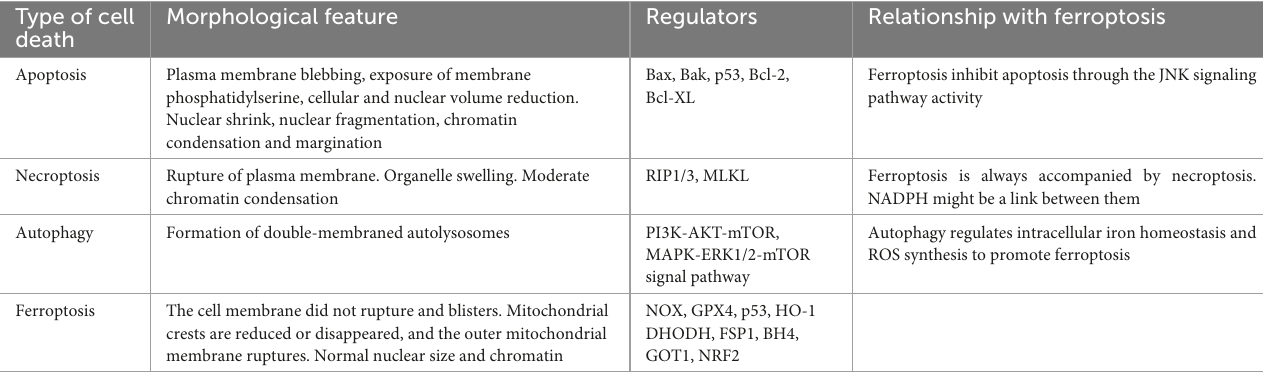
TABLE 1 The main feature of apoptosis, necroptosis, autophagy, ferroptosis. Type of cell